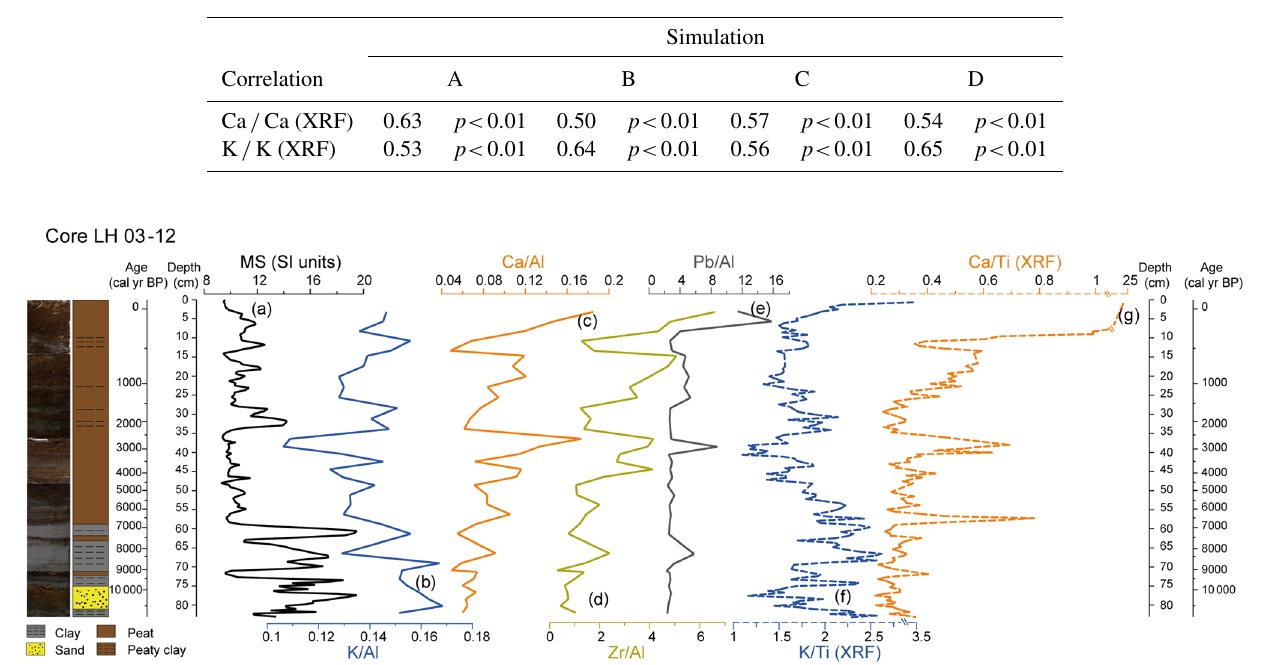
Figure 4. Detailed geochemical diagram of the LH 12-03 record showing the selected proxies: (a) MS; (b) K / Al; (c) Ca / Al; (d) Zr / Al; (e) Pb / Al; (f) K / Ti (XRF); (g) Ca / Ti (XRF) (MS in SI units, Zr / Al and Pb / Al scale × 10 − 4 and XRF in